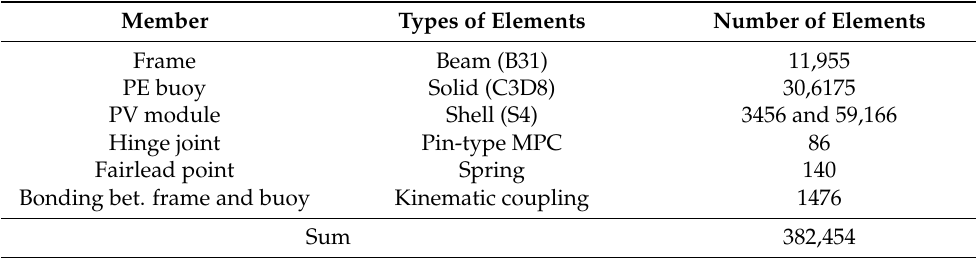
Table 5. Element information for structural frequency response